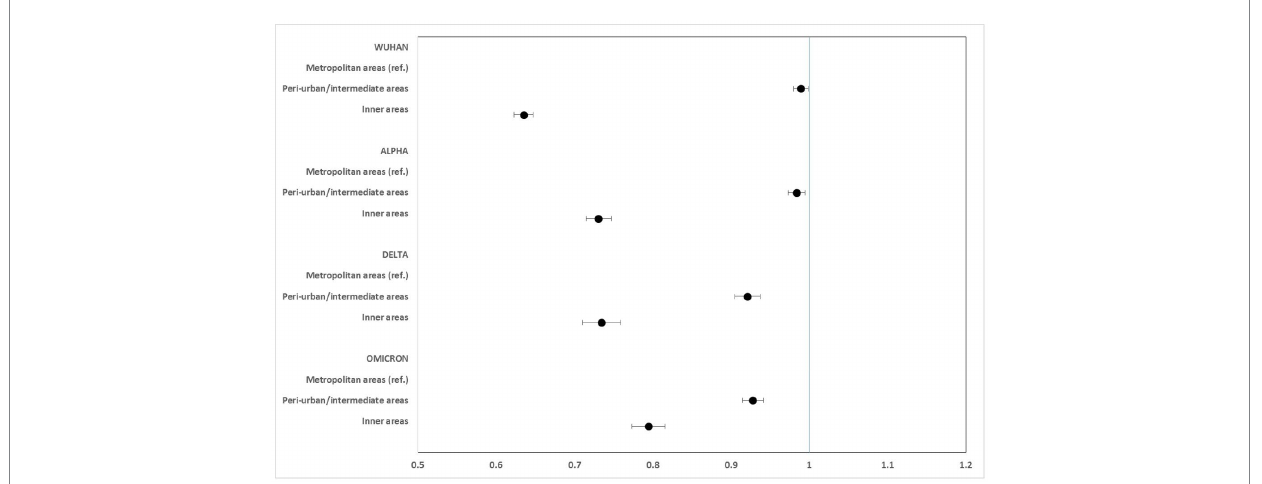
FIGURE 3 Age-adjusted rate ratios with 95%CI of non-ICU hospitalization, by study period and class of municipalities. Metropolitan areas as reference category.